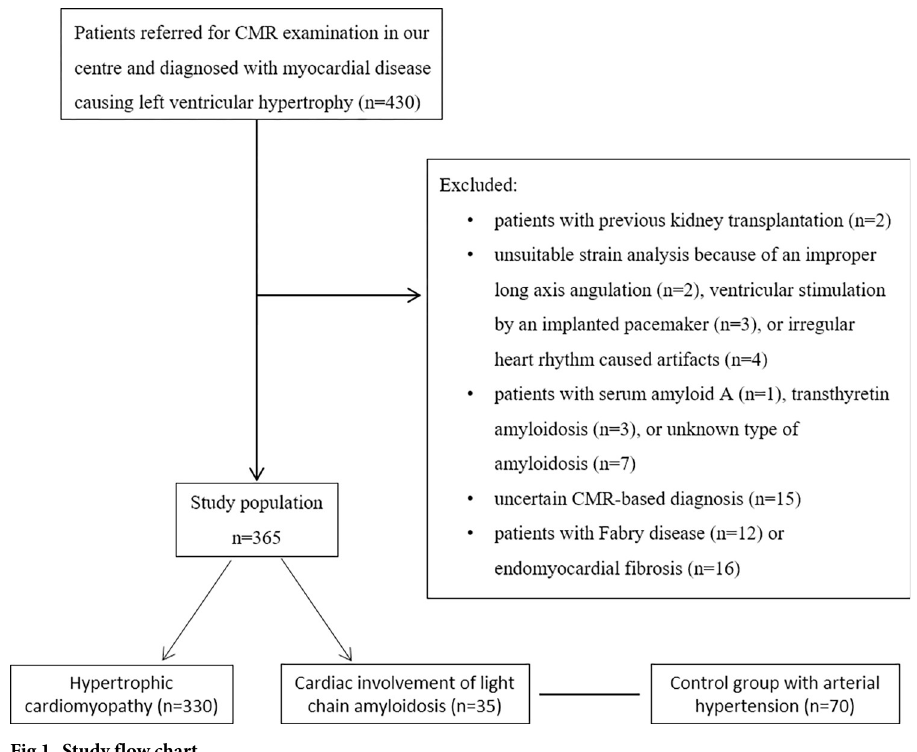
Fig 1. Study flow